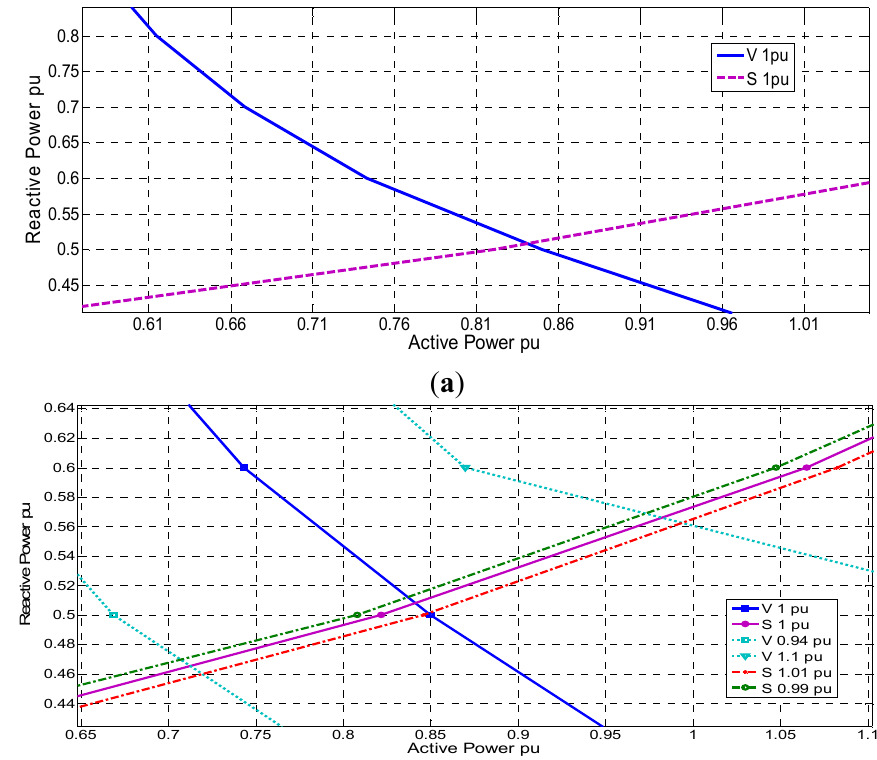
Figure 8. Feasible operating point and area, ( a ) Optimum active and reactive load; ( b ) speed limited to 1% and ( c ) speed limited to